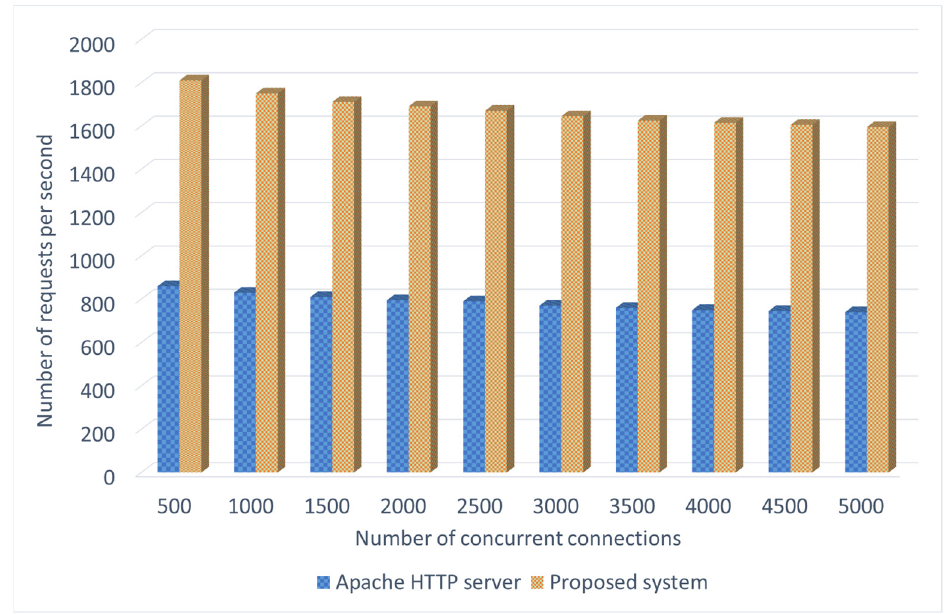
Figure 9. Comparison of the performance of firmware downloading. Table 2. Functionality